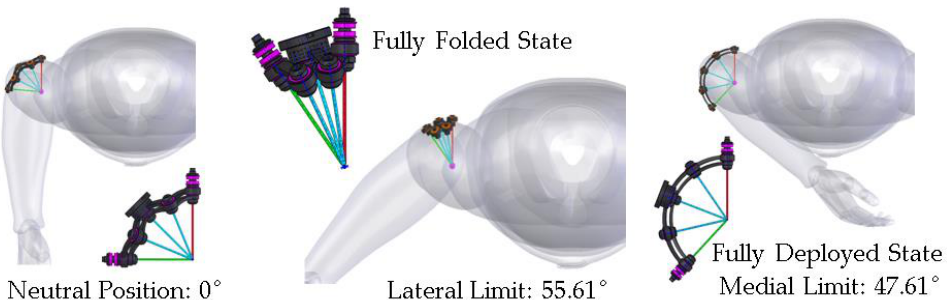
Figure 6. Wearing demonstration of the neutral, lateral limit, and medial limit state of the prototype